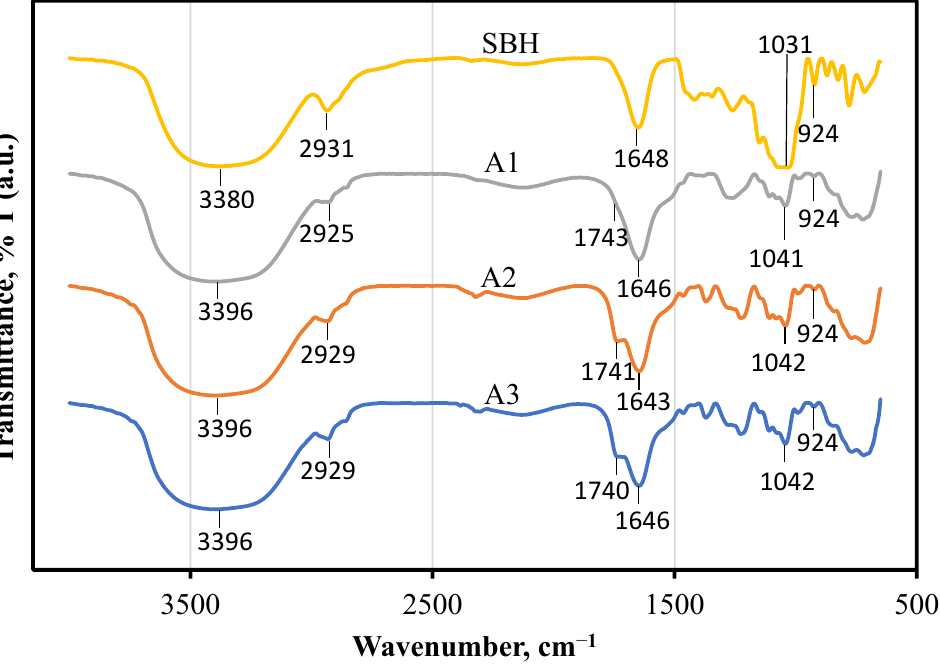
Figure 3. FTIR spectra of SBH and SBH NEs.